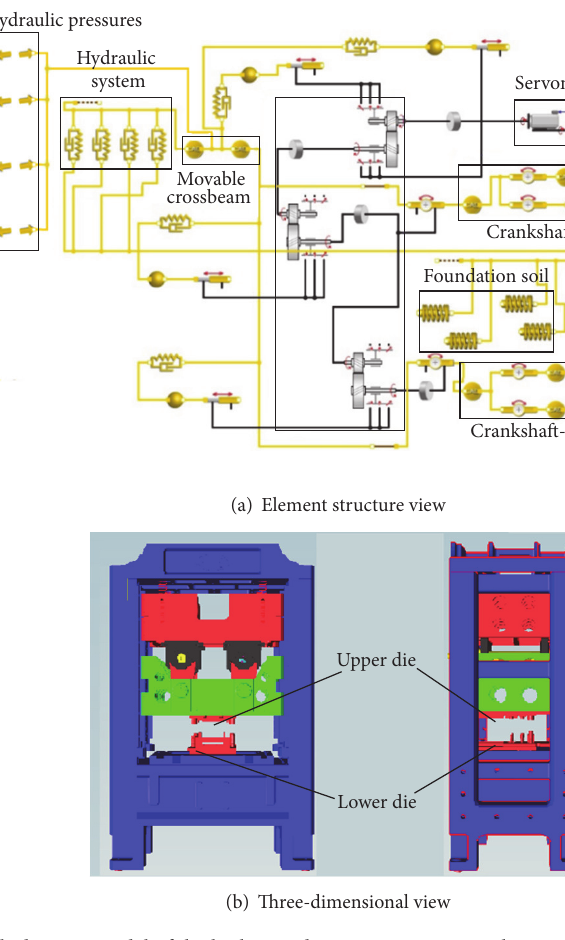
Figure 5: Multidomain model of the high-speed precision servo punching press based on SimulationX.